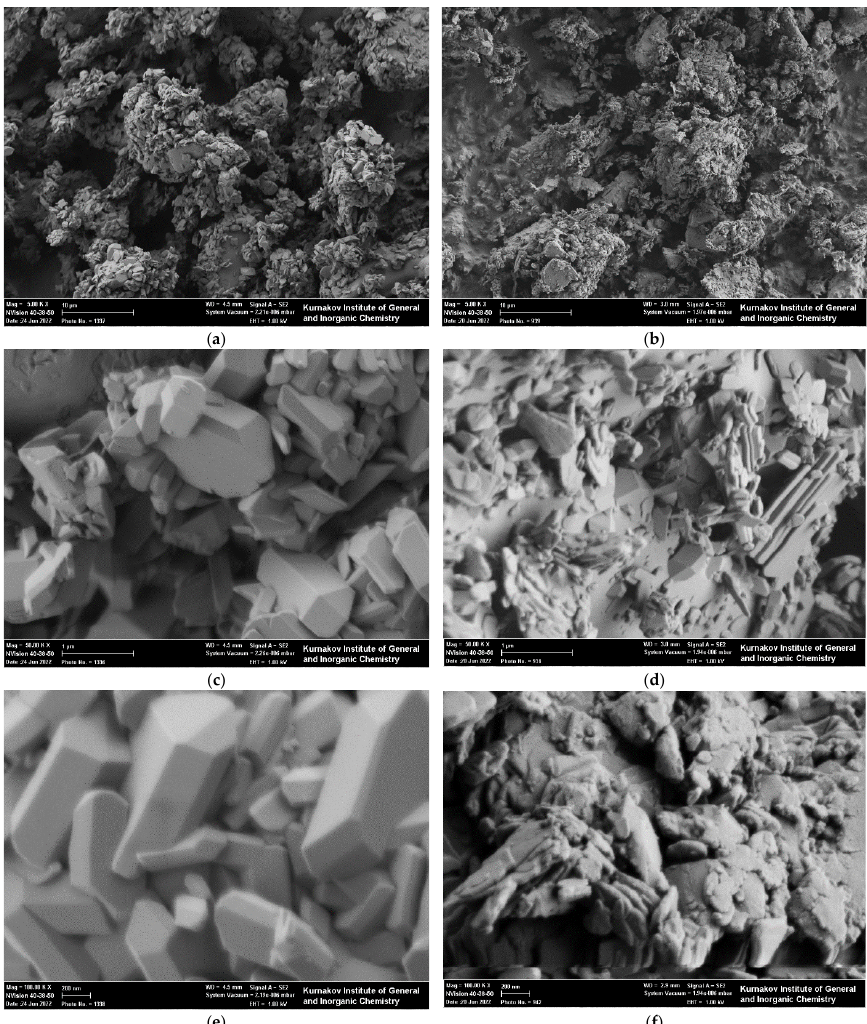
Figure 3. SEM images of the synthesized powder presented by brushite CaHPO 4 ‧ 2H 2 O as a predom- inant phase ( a , c , e ) and the powder mixture of synthesized powder and calcium citrate